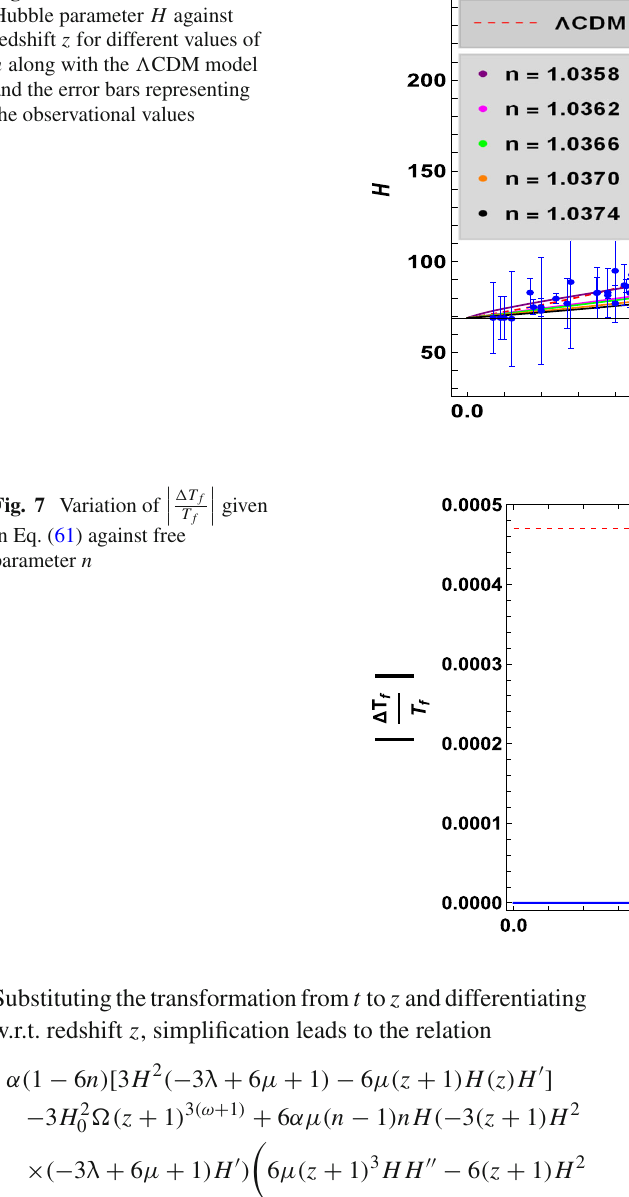
Fig. 6 The evolution of the Hubble parameter H against redshift z for different values of n along with the (cid:2) CDM model and the error bars representing the observational values